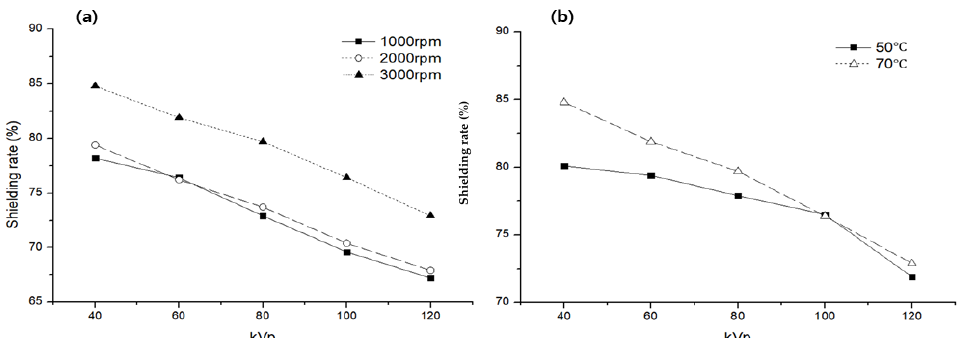
Figure 7. Changes in the shielding performance of the protective cream according to the speed (rpm) and temperature of the homo mixer: ( a ) shielding performance according to rpm, ( b ) shielding per- formance according to temperature.